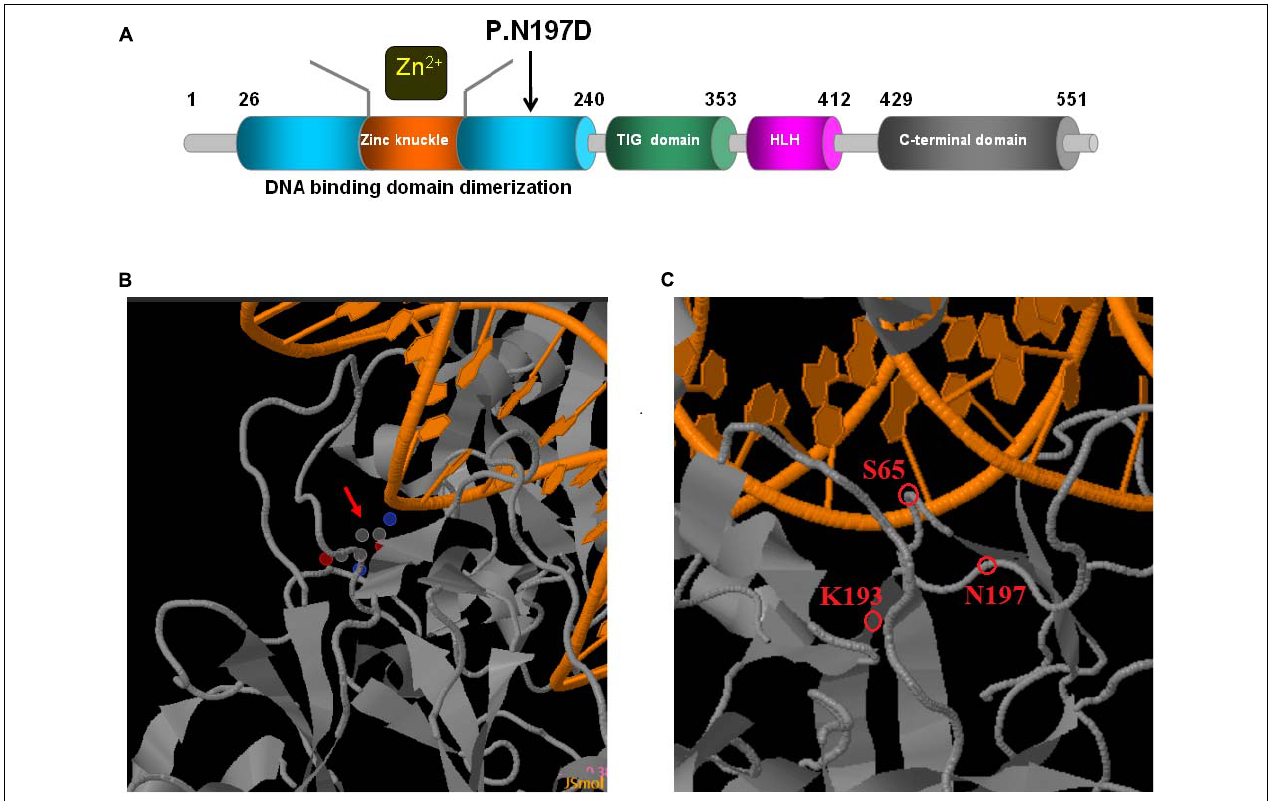
FIGURE 5 | Schematic representations of EBF3 structure. (A) The EBF3 protein consists a DNA-binding domain with special zinc knuckle, an Ig-like/plexins/transcription factors domain, an atypical HLH domain, and a C-terminal transactivation domain. The mutant amino acid identified in this study is shown in black arrow. (B,C) Close up of DNA-binding interactions of the variant (generated with JSmol). The protein is shown in gray, and the DNA is shown in orange. Asn197 is interacted with DNA. Asn197 is close to Lys193 which participated in the electrostatic network of interactions with the DNA phosphate backbone and the carbonyl oxygen of